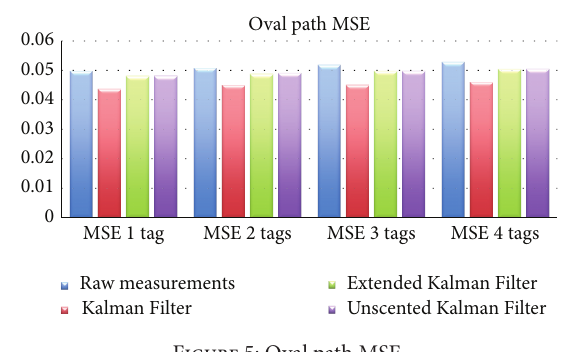
Figure 5: Oval path MSE.